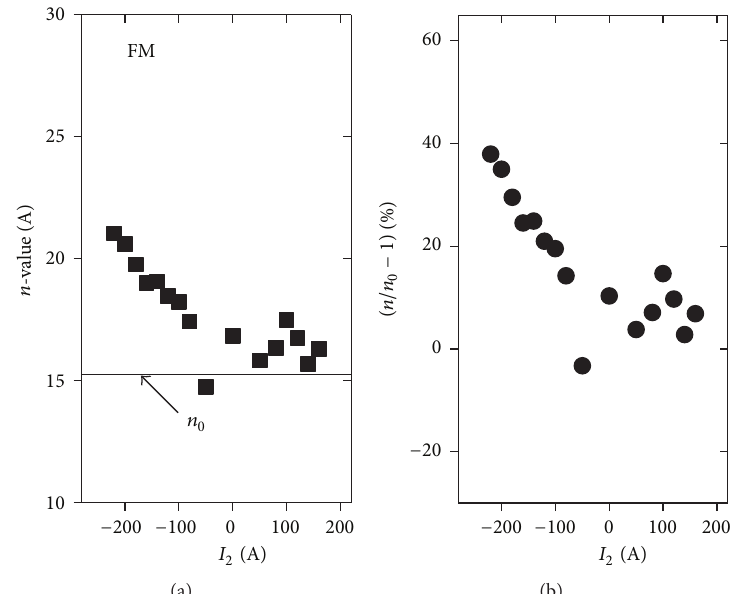
Figure 8: (a) 𝑛 -value versus the applied current to the neighboring tapes and (b) increase of 𝑛 -value with respect to the neighboring current for three-layer stacked conductor with